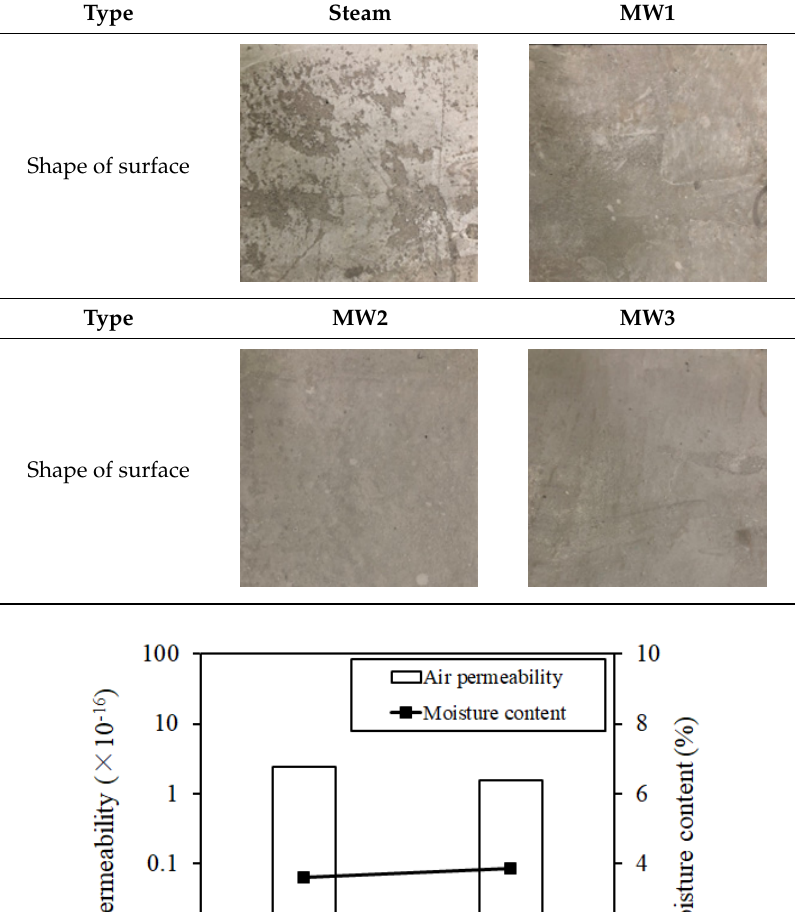
Table 6. Surface condition of concrete at the age of 28 days.